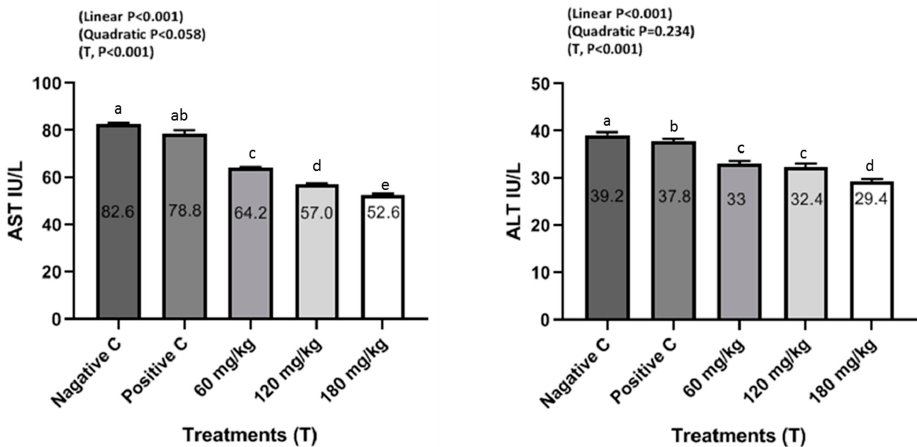
Figure 2. Liver enzyme (alanine transaminase (ALT) and aspartate transaminase (AST)) levels of male rabbits in response to dietary treatments including a basal diet (NC), a basal diet supplemented with a 500 mg / kg oxytetracycline antibiotic (PC), and a basal diet supplemented with 60, 120, or 180 mg / kg of TEO at 130 days of age. a–e Means within a row with different superscripts differ significantly at P < 0.05.